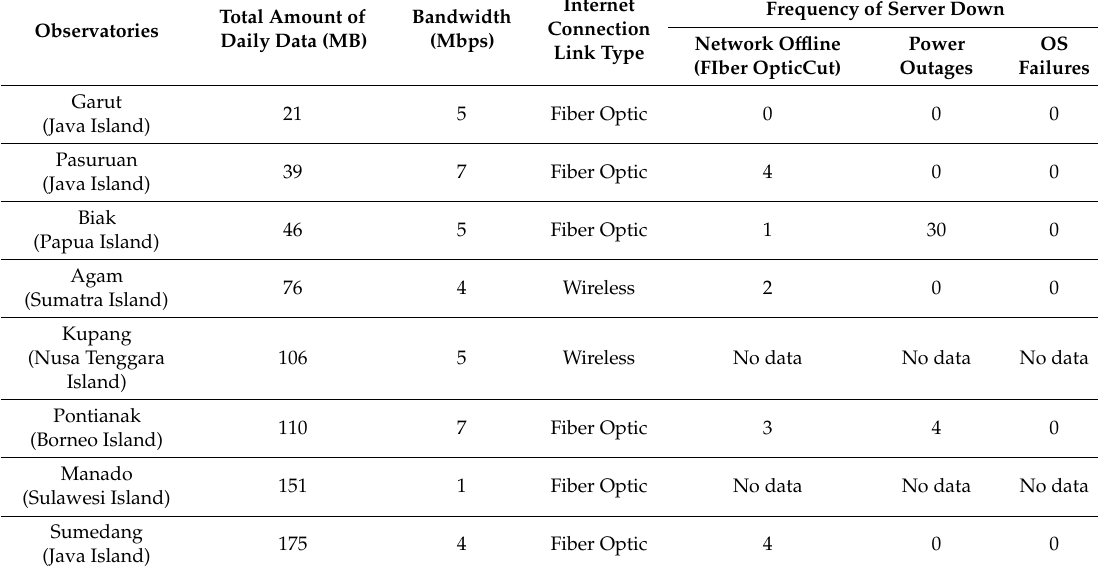
Table 1. Observatories status in Q1 of